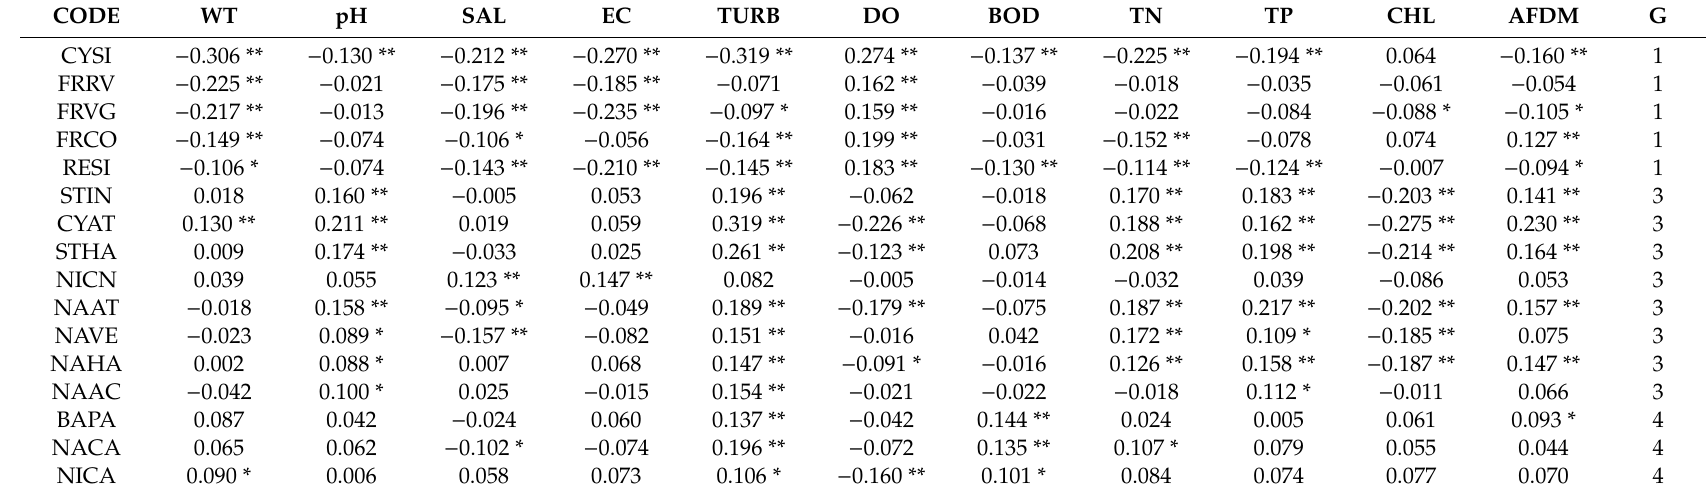
Table 4. Relationship between indicator species and environmental variables in each diatom group in Korean estuaries between 2009 and 2016. Groups were divided by cluster analysis with diatom abundance and appearance. CODE (name of diatom) cited from Table